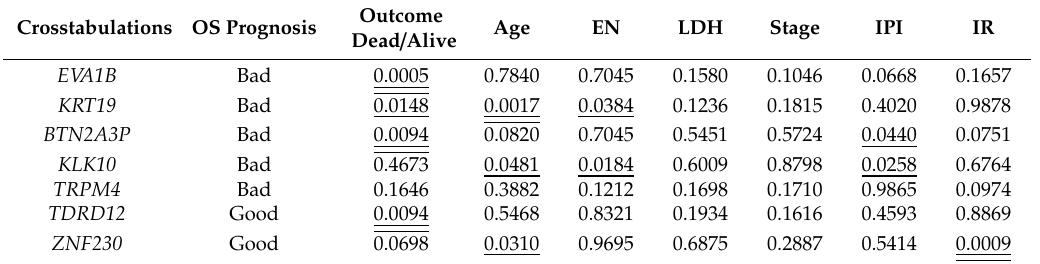
Table 7. Clinicopathological correlations with the final set of seven prognostic